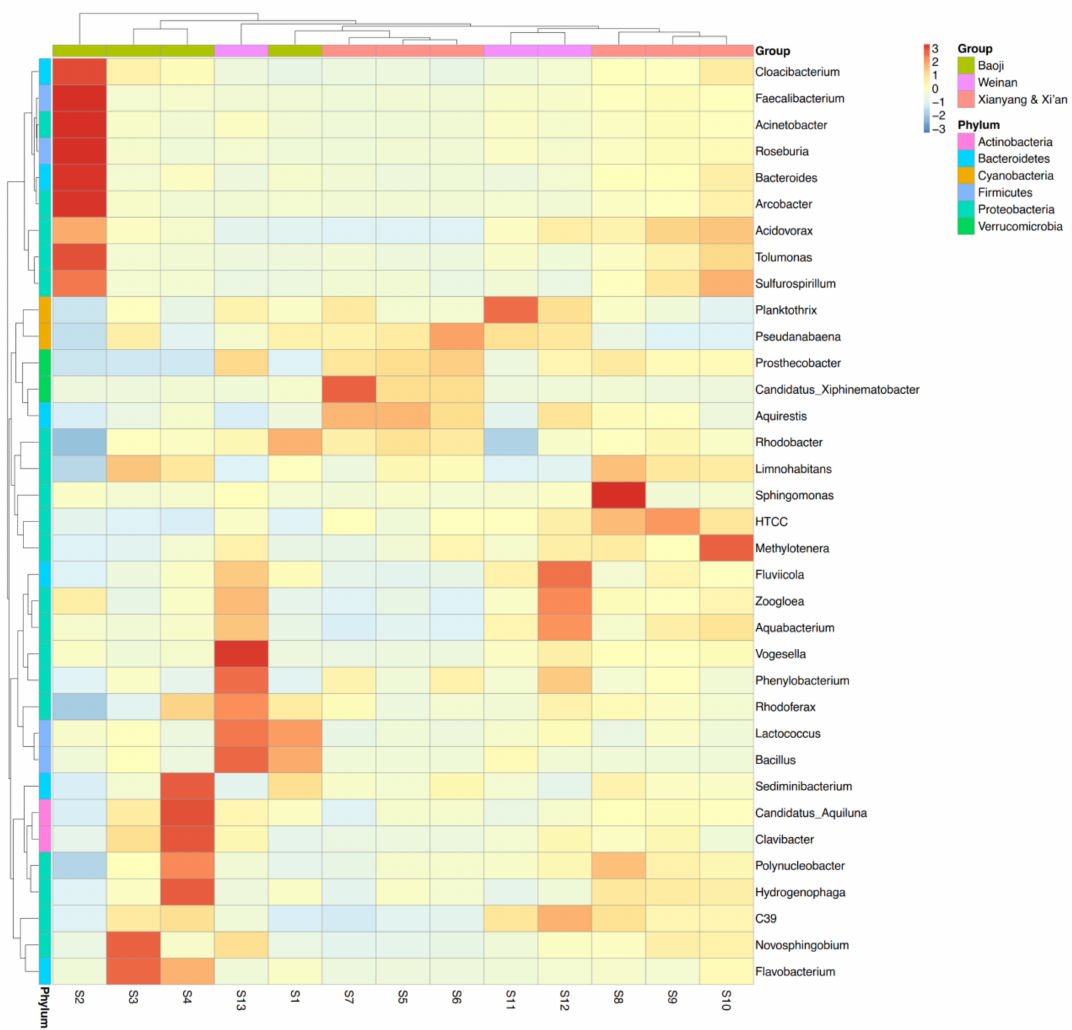
Figure 4. Heatmap showing the relative abundances of the 35 most abundant genera in the 13 water